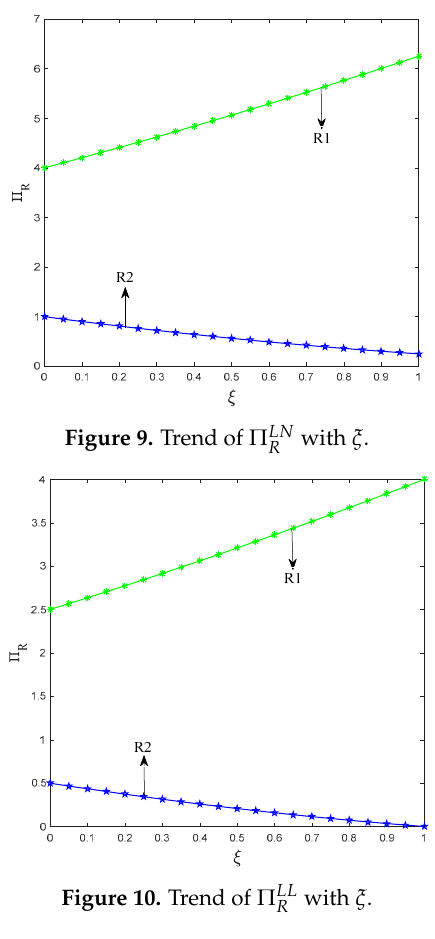
Figure 10. Trend of Π (cid:3019)(cid:3013)(cid:3013) with ξ .